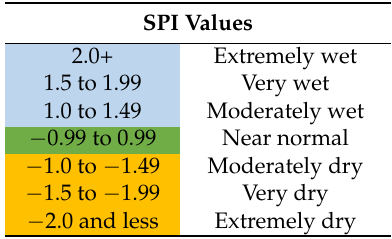
Table 3. The SPI value is the number of standard deviations by which the observed anomaly deviates from the long-term mean. SPI values from − 2.0 and less to − 1.0 identify dry periods, from − 0.99 to 0.99 identify near normal periods and from 1.0 to 2.0+ identify wet